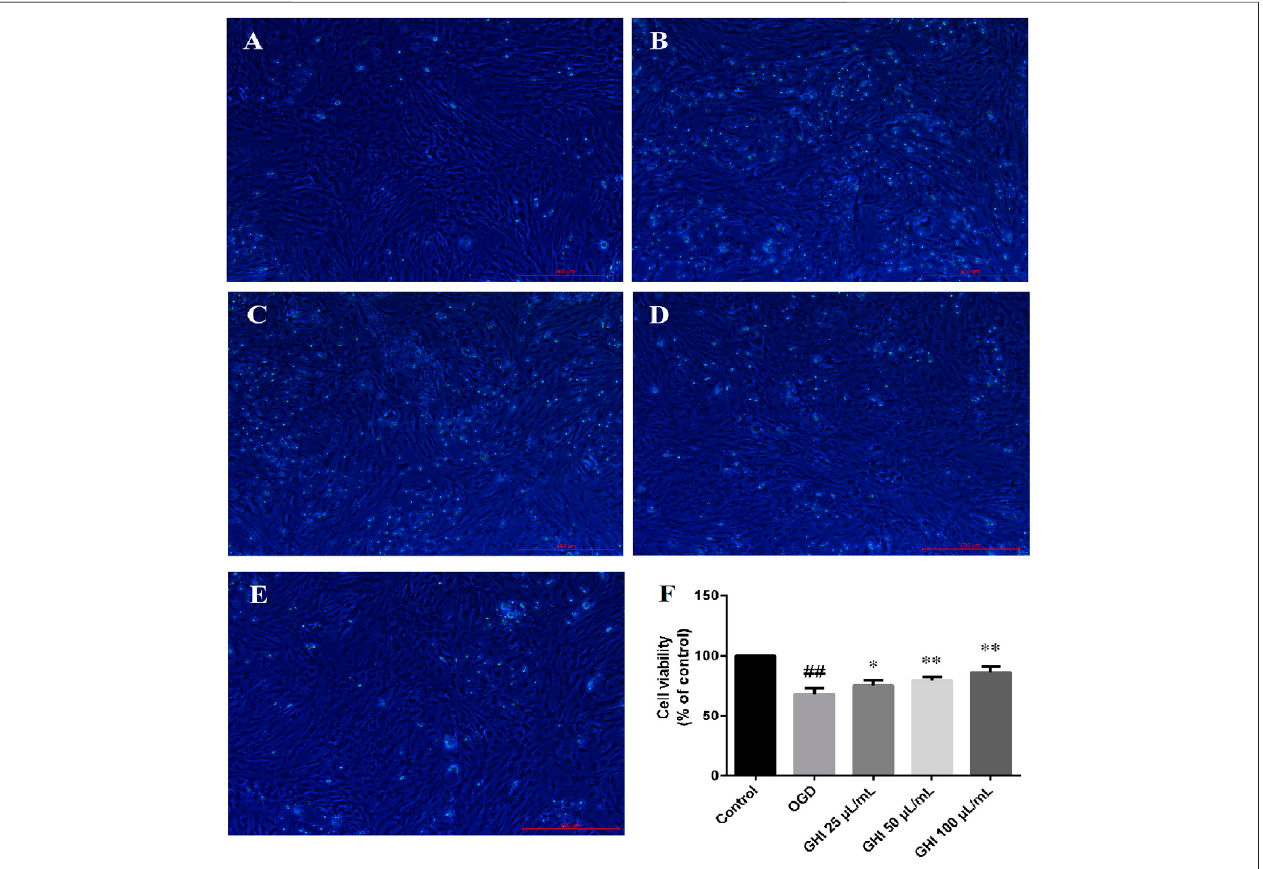
FIGURE 8| Effects of GHI on OGD-induced changesin cell morphology and viability (n (cid:2) 6). (A) Control group, (B) OGD group, (C) GHI 25 μ L/ml, (E) GHI 100 μ L/ ml, and (F) cell viability. ## P < 0.01 compared with the Control group; * p < 0.05, ** p < 0.01 compared with the OGD group.